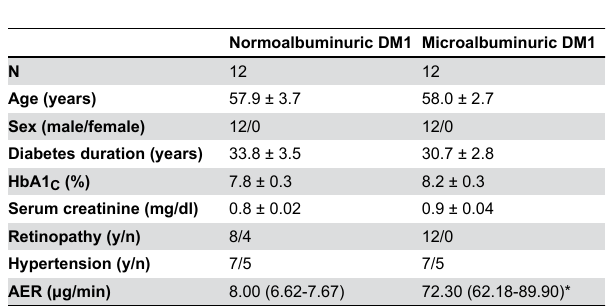
Table 2. MiR-130a, miR-424, miR-155, miR-145 content in urinary exosomes from diabetic patients and non-diabetic control